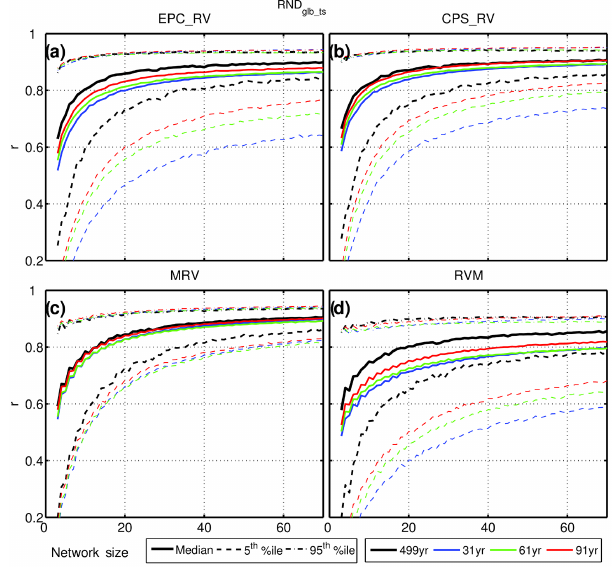
Figure 8. Reconstruction skill for different experiments (as indi- cated by colour) and reconstruction methods (each panel) using dif- ferent calibration window lengths (see inset legend). The lines show the proportion of skilful reconstructions, with skilful being defined as explaining greater than 50% of the explained variance of the Niño 3.4 running variance.